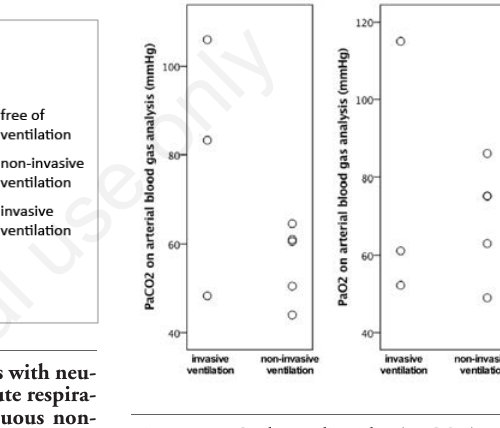
Figure 2. Carbon dioxide (PaCO2) and oxygen (PaO2) on arterial blood gas analy- sis before starting noninvasive mechanical